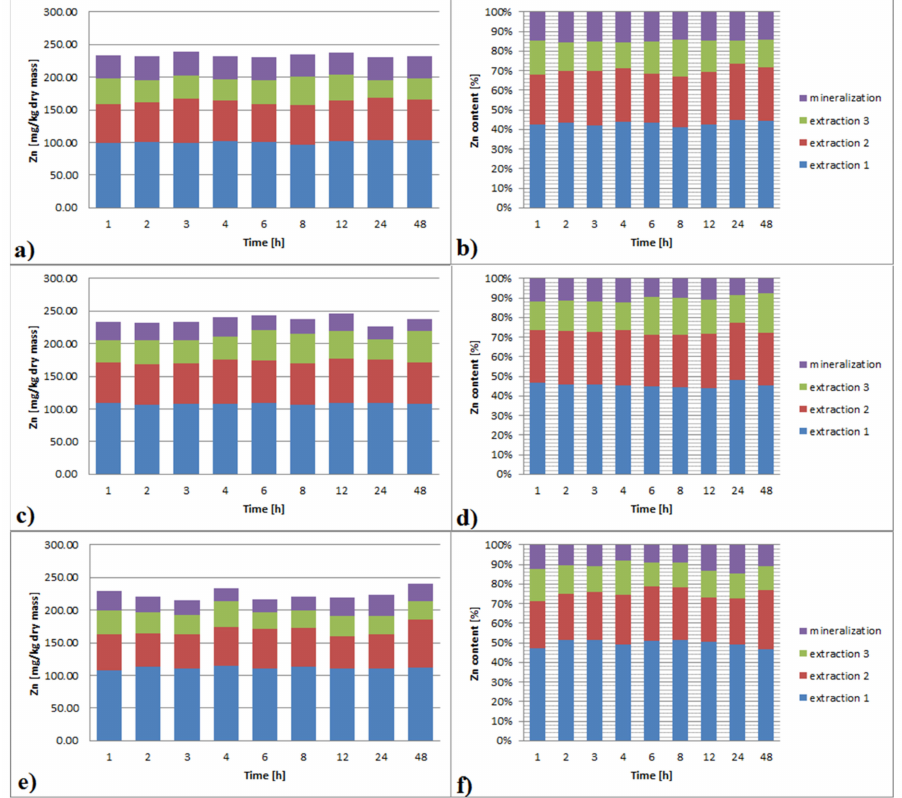
Figure 4. ( a – f ). Zn extraction from bottom sediments with different EDTA concentrations ( a , b ): 0.01 M; ( c , d ): 0.05 M; ( e , f ): 0.1 M and extraction